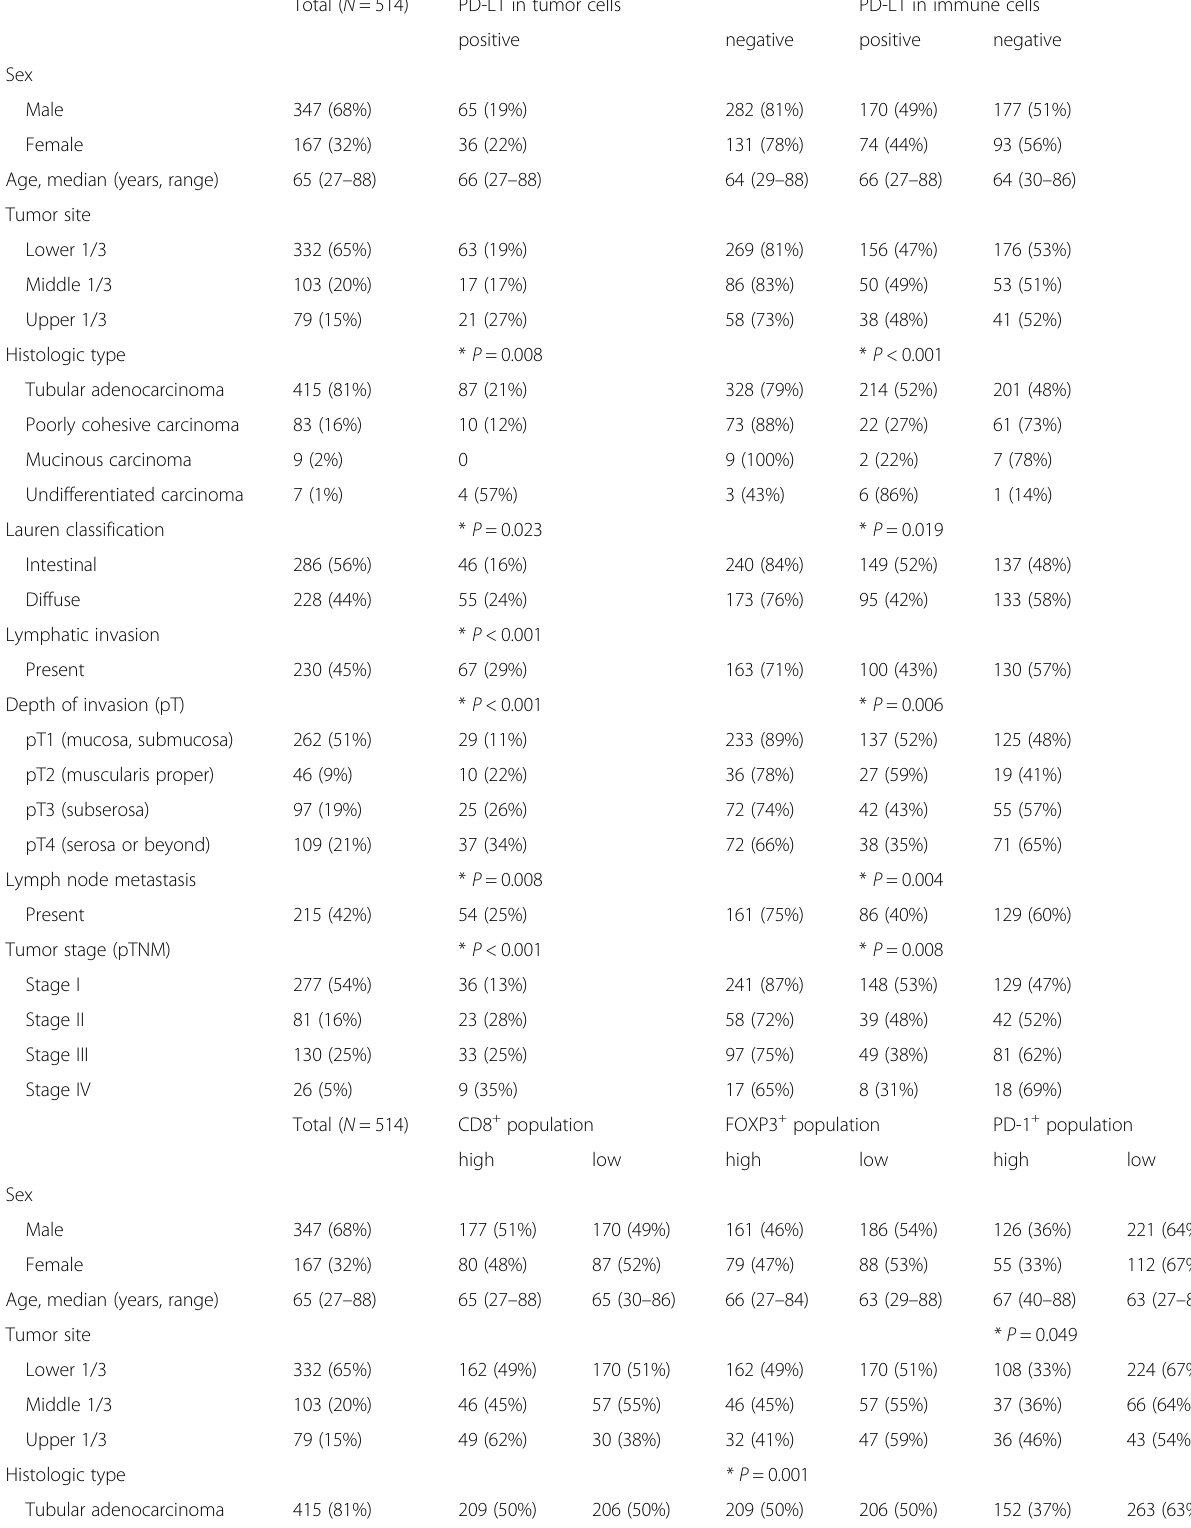
Table 1 Relationship Between Clinicopathological Features and PD-L1 Expression and Tumor-Infiltrating Lymphocytes in the